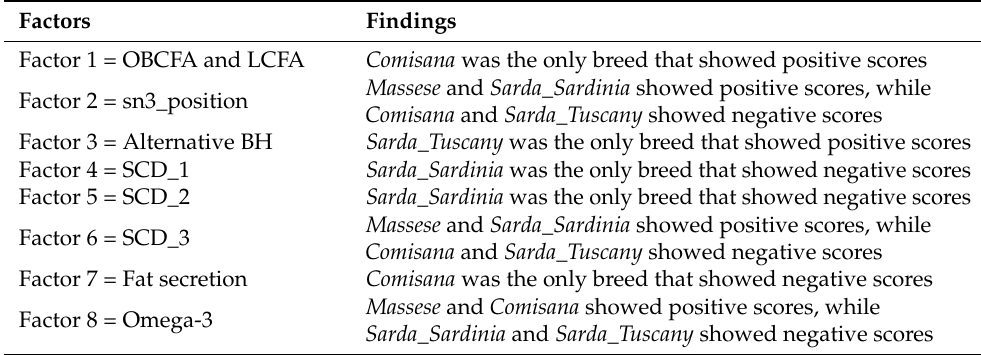
Table 3. Summary of findings regarding factors and breeds.